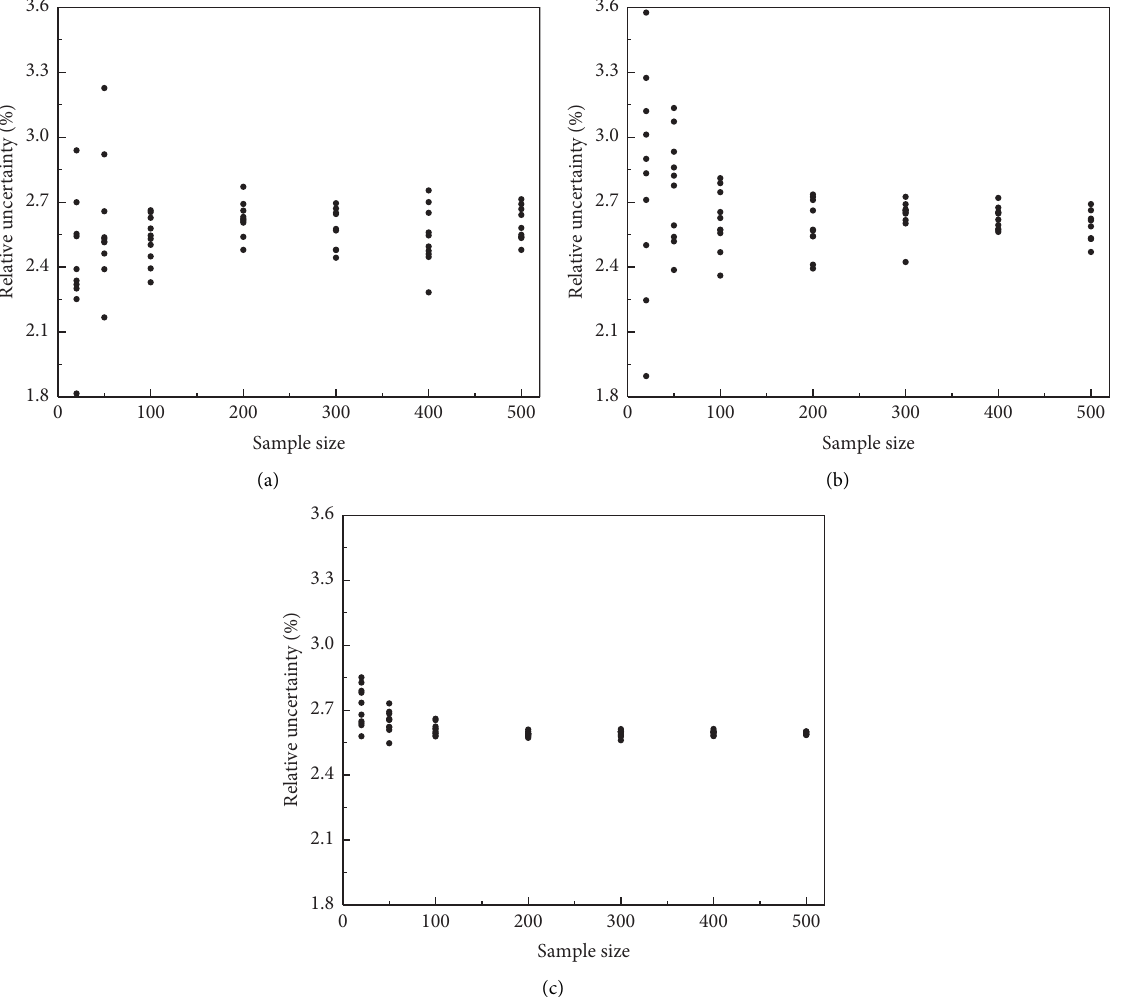
Figure 17: The 10 sets of the relative uncertainty of the maximum fuel temperature due to the random samples generated by (a) SRS, (b) LHS, and (c)